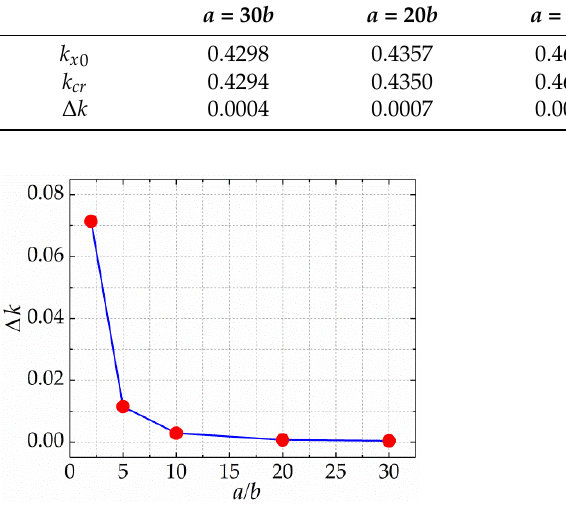
Figure 4. Relationship between Δ k and a / b .